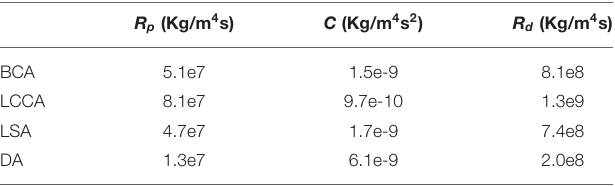
TABLE 2 | Table reporting the parameters for the Windkessel models for the non-linear FSI simulation.